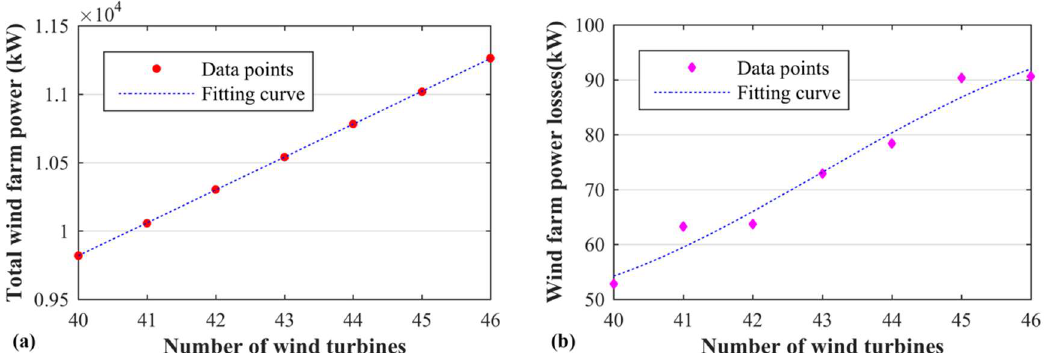
Figure 12. Results of wind farm layout optimization with different number of wind turbines under Weibull distribution wind condition: ( a ) wind farm power production and ( b ) wind farm power losses.